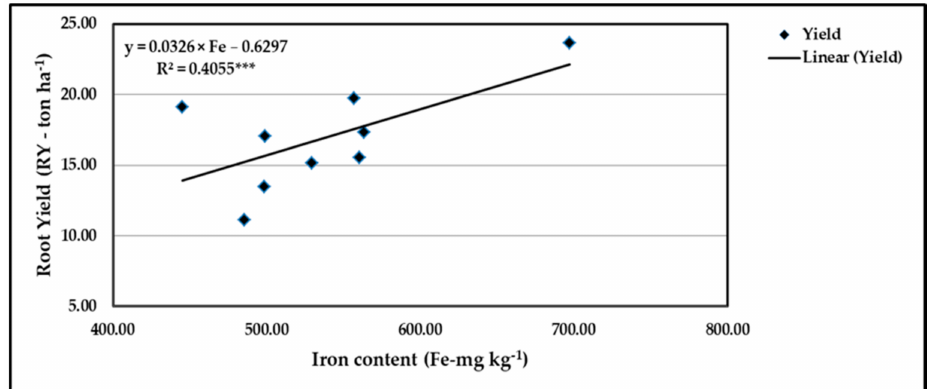
Figure 18. Contribution of Fe content to the quadratic response of stressed sweet potato to different levels of ascorbic acid and zinc oxide nanoparticles in the 2020 season. *** indicates differences at p ≤ 0.001 probability